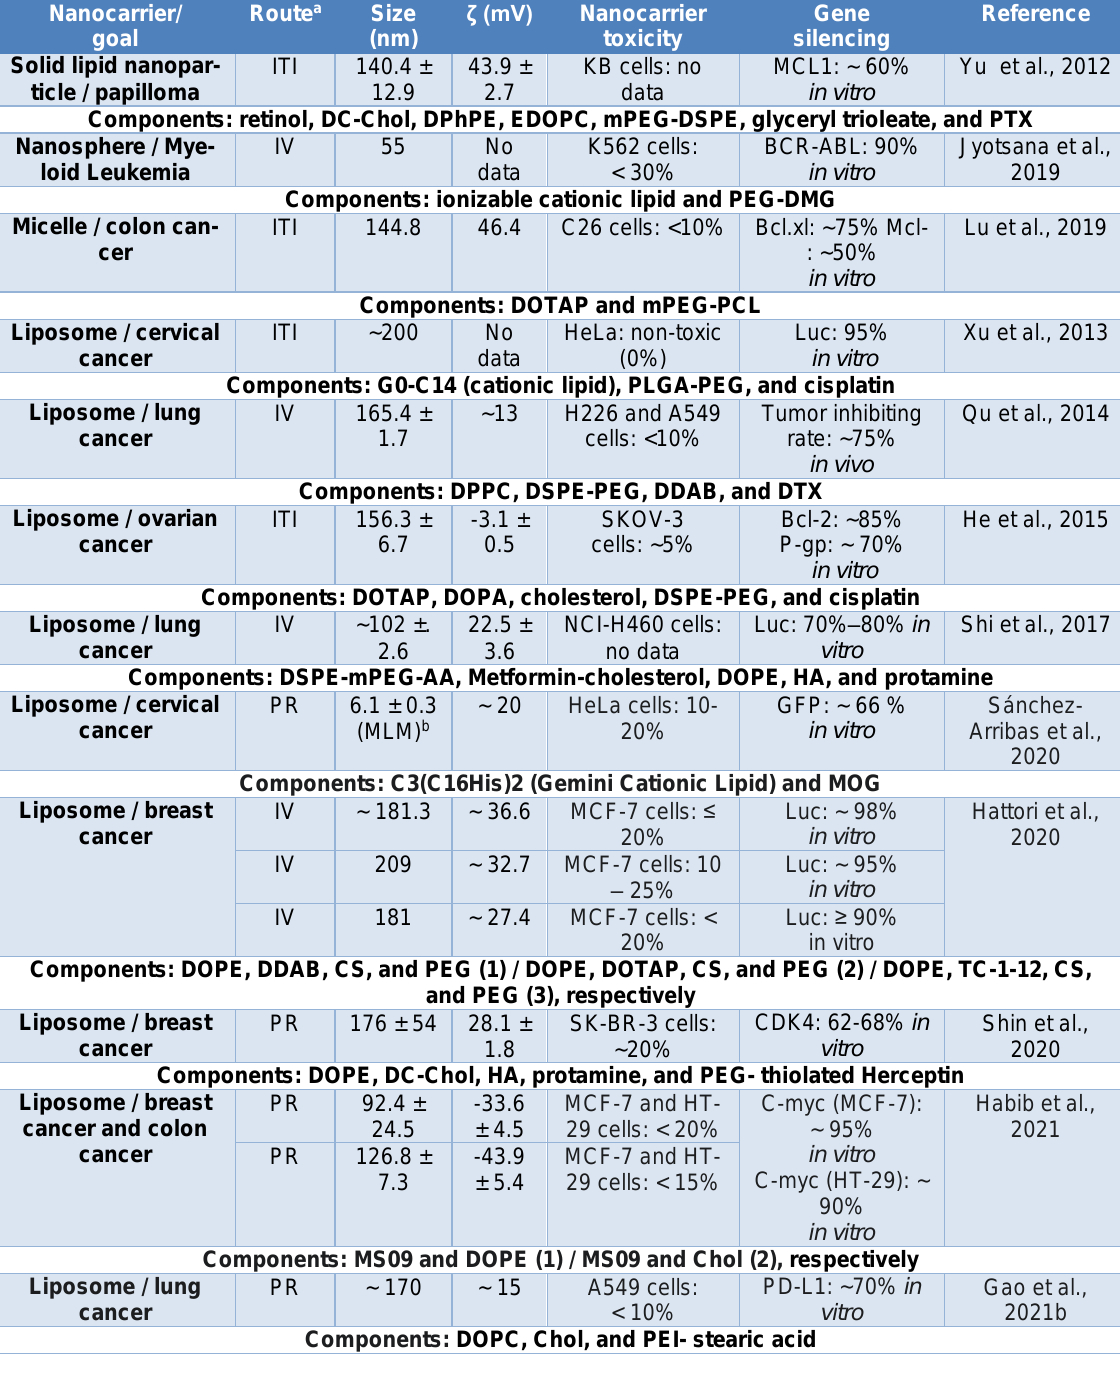
Table 1: Nanocarriers composed of lipid nanoparticles